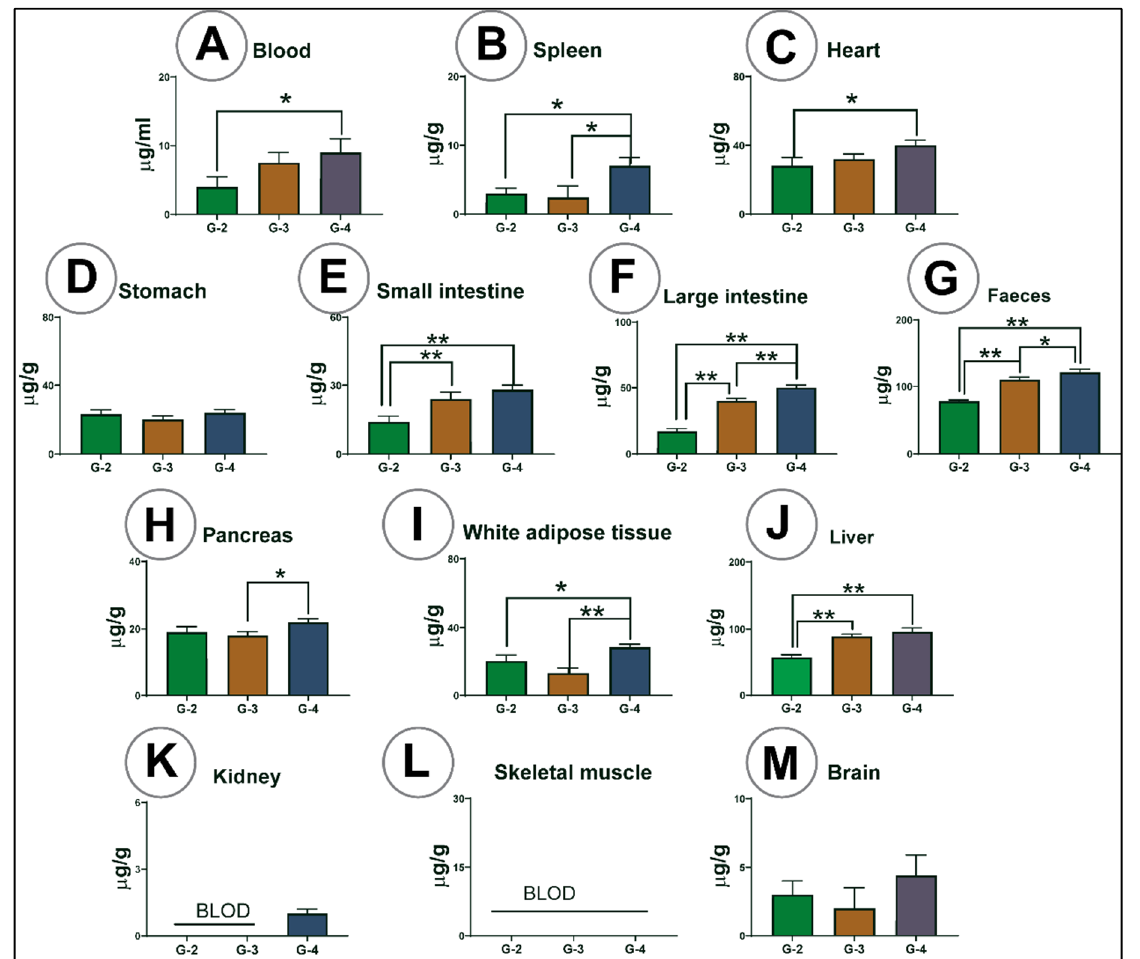
Figure 7. PB concentration (μg/mL or μg/g) in blood (A), spleen (B), heart (C), stomach (D), small intestine (E), large intestine (F), faeces (G), pancreas (H), white adipose tissue (I), liver (J), kidney (K), skeletal muscle (L) and brain (M). G-2 = mice treated with free PB, G-3 = mice treated with PB-SA = F1 microcapsules, G = 4 mice treated with PB-LCA-SA = F2 microcapsules. BLOD = below the limit of detection. Data are presented as mean ± SD. p < 0.05*, p < 0.01**.